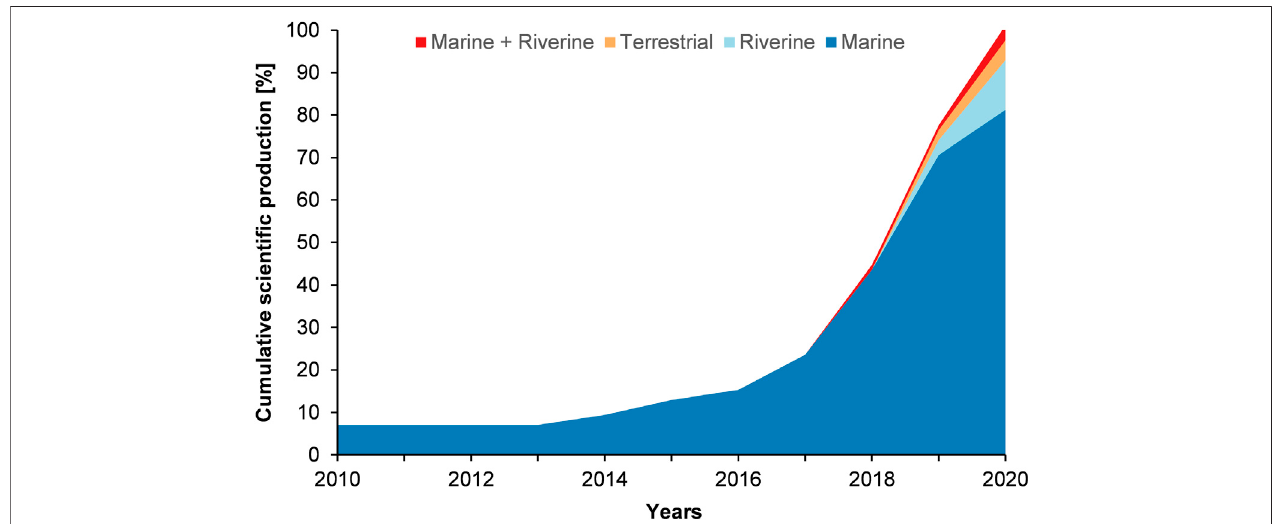
FIGURE 1 | Research output on plastic pollution in Indonesia per environmental system over time. Dark blue represents studies concerning plastic pollution in the marine environment, lightblue represents studies concerning pollution intheriverine environment, orange represents researchstudiesconcerning plasticpollutioninthe terrestrial environment, and red represents studies concerning both marine and riverine environment. Output from 1986 – 2009 was omitted due to incompatibility to current scienti fi c standards, output for 2020 was cut off on October 1, 2020.